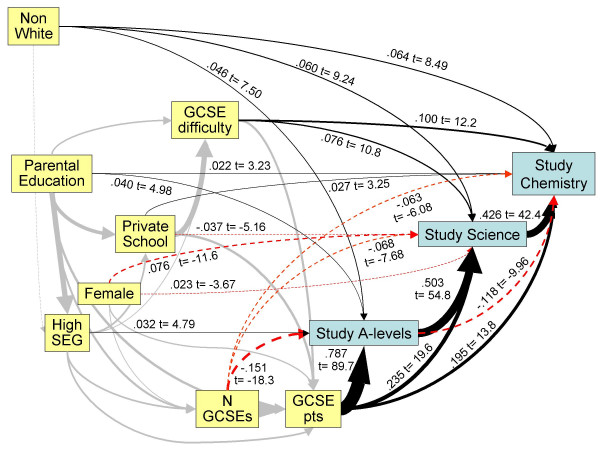
Path model of influences of background factors and GCSE performance (variables in yellow) upon taking of A-levels, science A-levels and A-level chemistry (variables in blue). Path coefficients and t-statistics are shown alongside paths, the thickness of paths is proportional to the path coefficient, and negative paths are shown as red, dashed lines. Paths previously shown in figure 2 are in pale grey without coefficients, to avoid undue confusion.